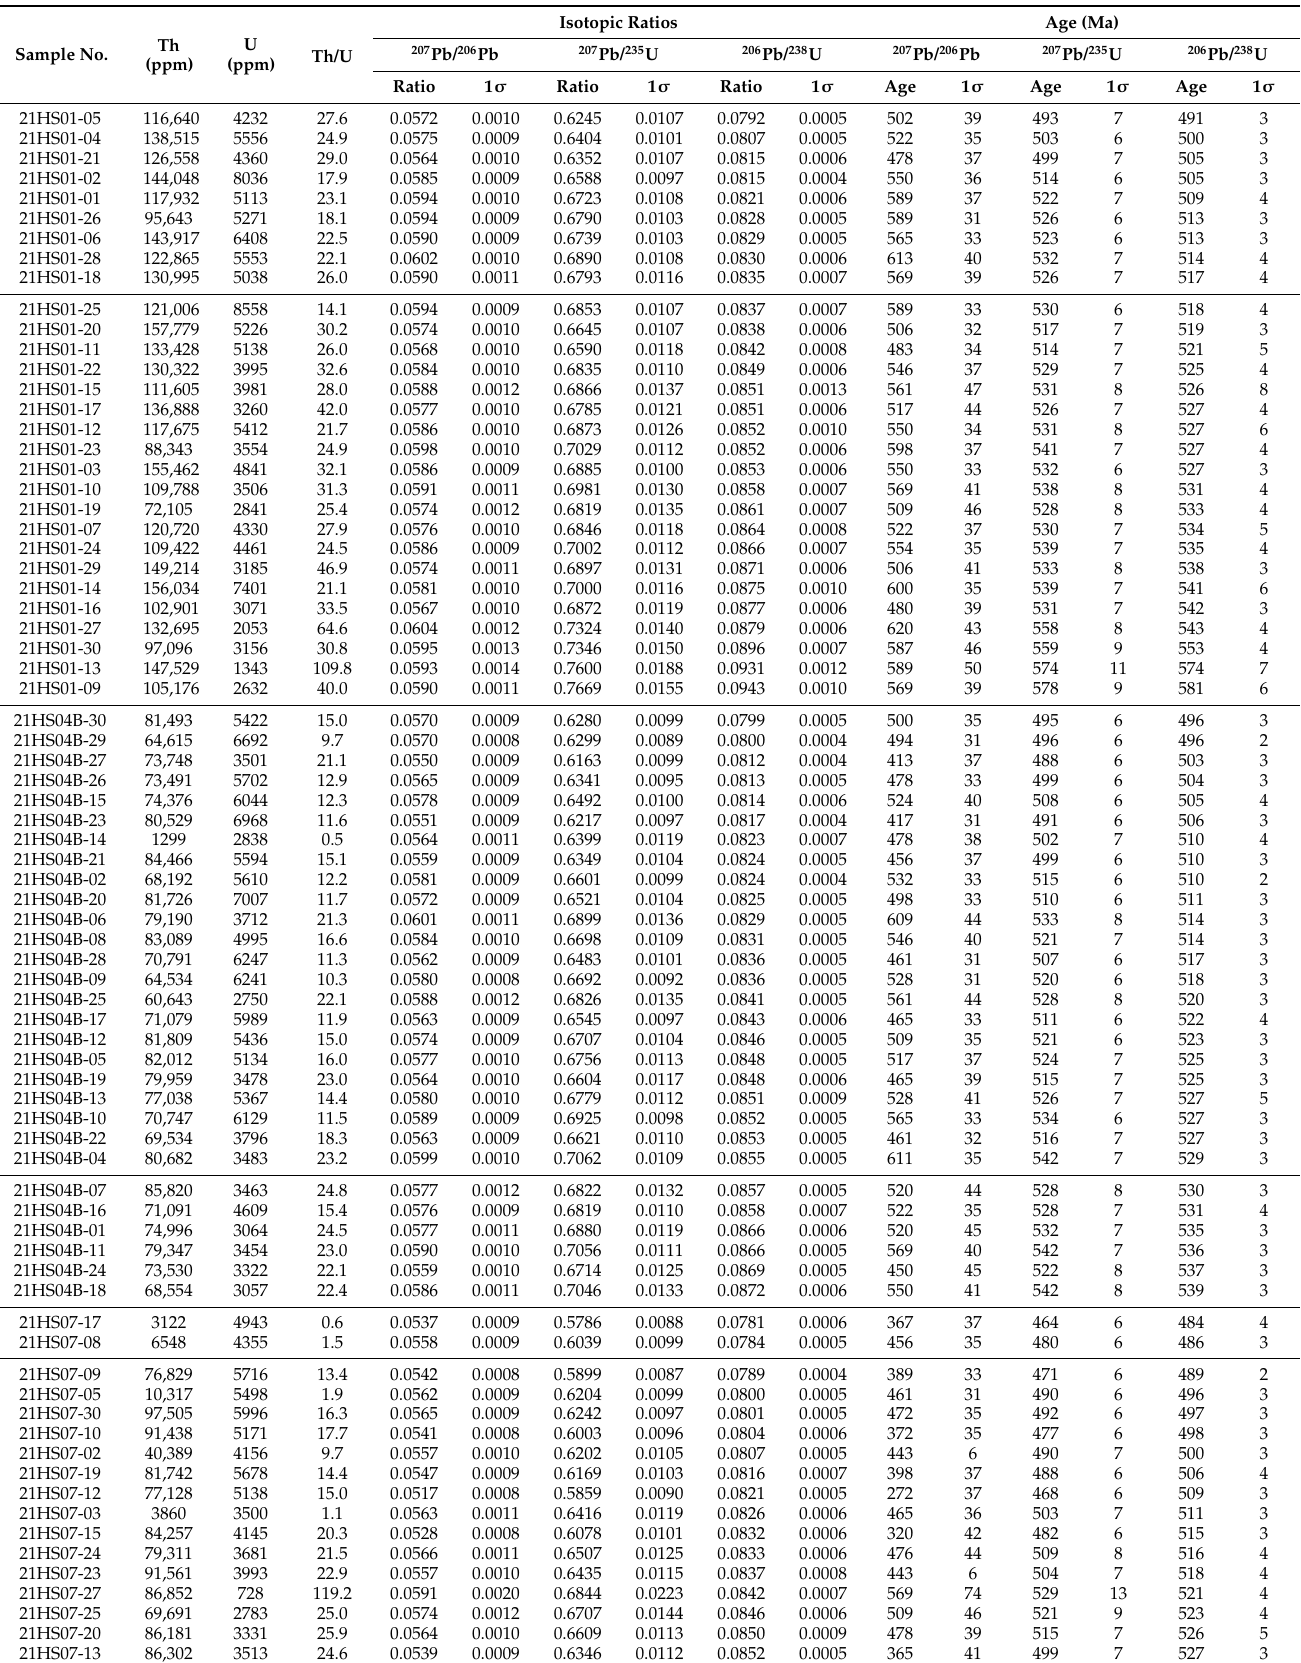
Table 2. LA-ICP-MS monazite age data from the Abbabis Metamorphic Complex.